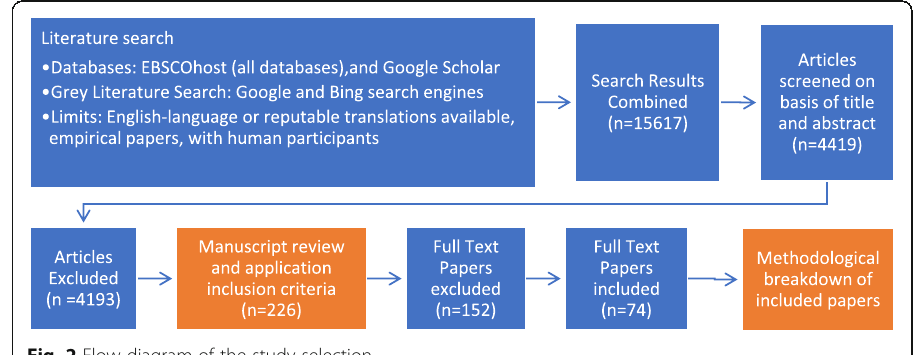
Fig. 2 Flow diagram of the study